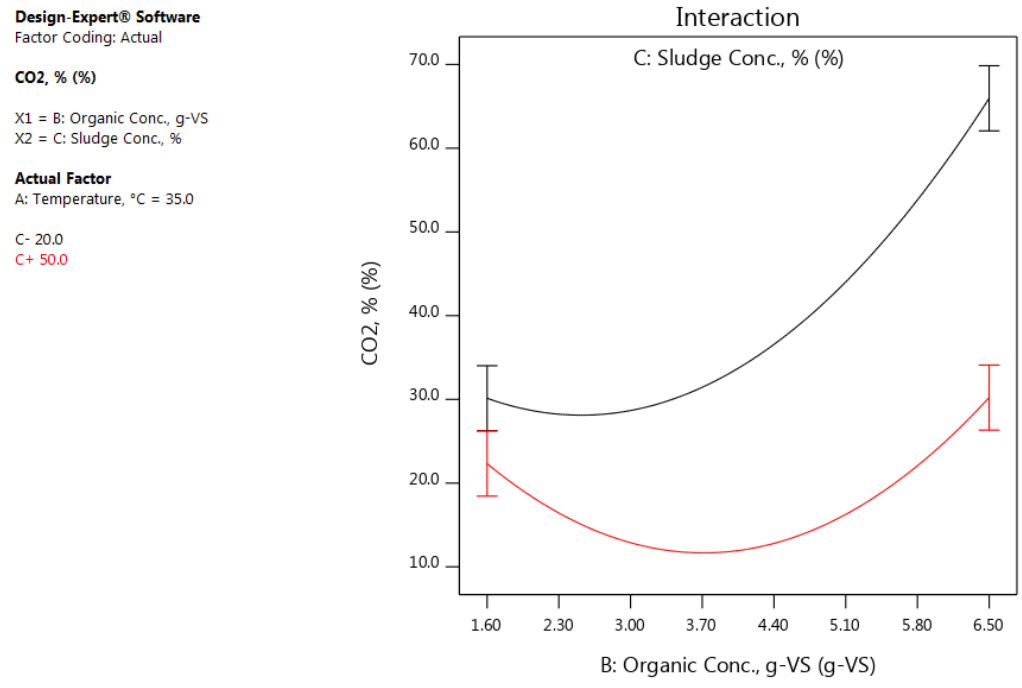
Figure 12. An interaction plot shows the influence of the BC interaction on the CO 2 %.